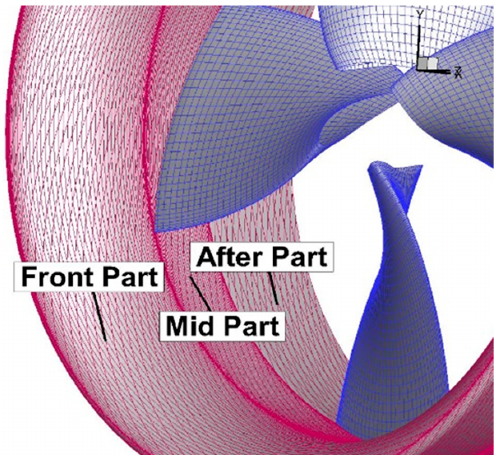
Figure 17. Paneling regions on the inner duct surface. The hub geometry is not included for clarity.